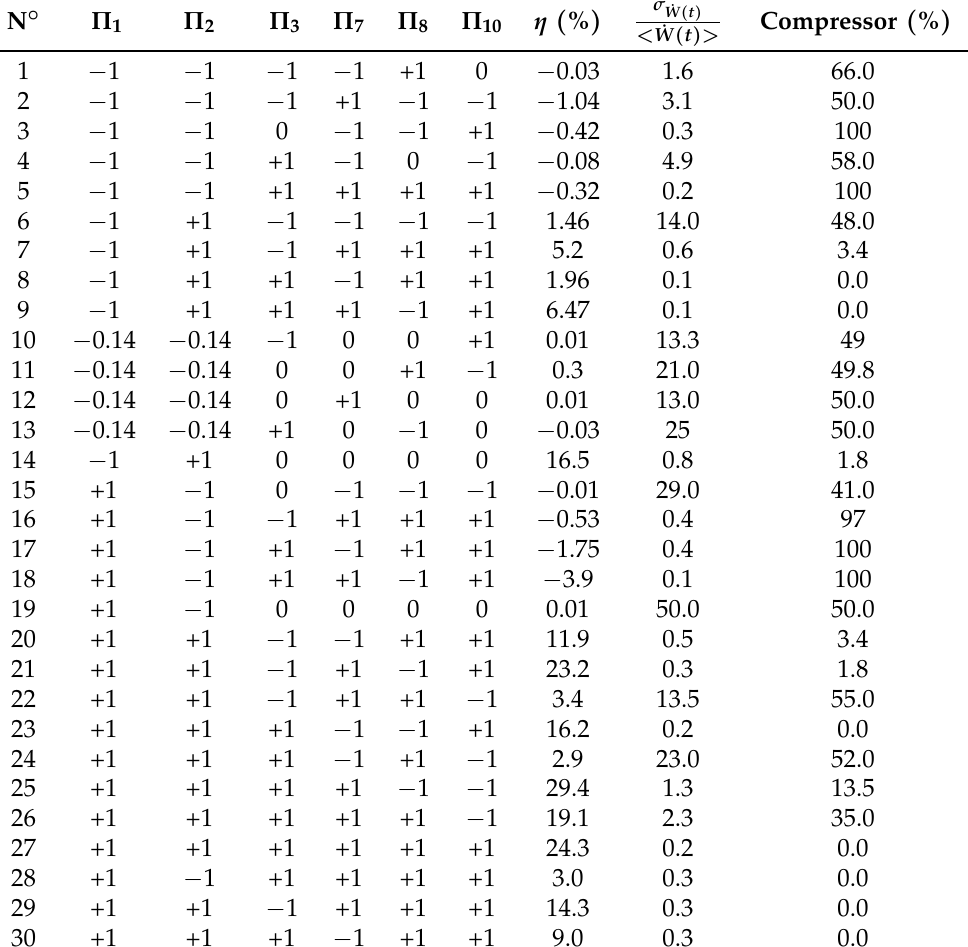
Table 5. Surface response design selected and associated